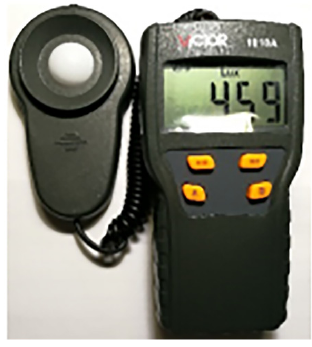
Figure 13. Figure 13. Illuminometer. Table 1. Data comparison table of left illuminance sensor and illuminometer.